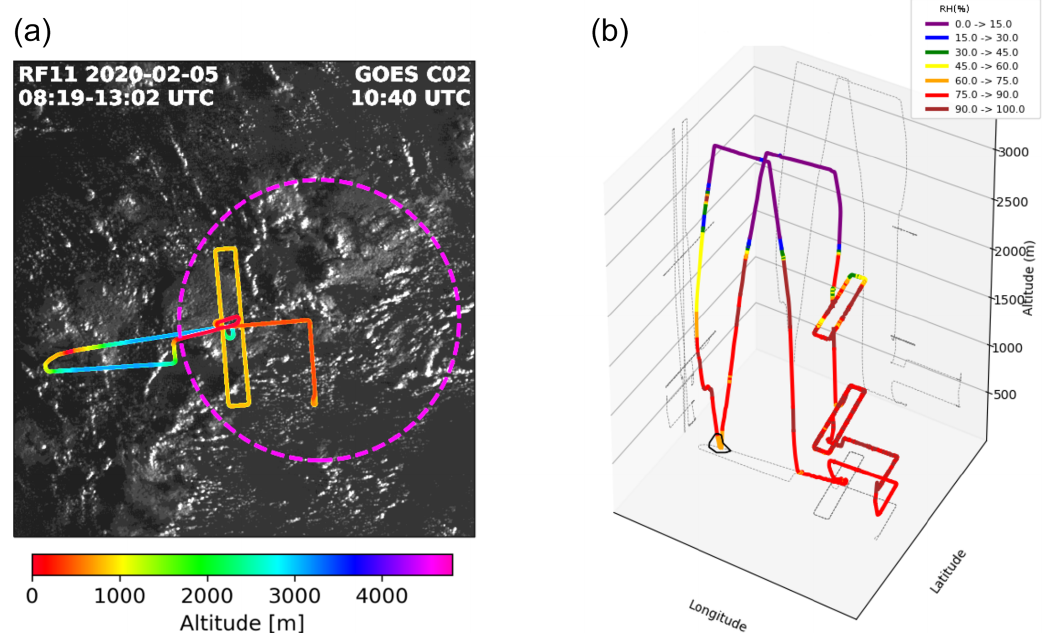
Figure 2. (a) Longitude–latitude trajectories of the ATR colored by the flight altitude (for repetitive flight patterns such as the rectangles, only the last repetition is visible due to overlap). The dashed circle represents the EUREC 4 A circle. The ATR track is shown for RF11 (5 February) on top of a satellite snapshot of the domain (11.8–14.8 ◦ N, 57–60 ◦ W) derived from the visible channel of GOES-16 at about mid-flight time (the tracks of all other flights are shown in Fig. C2). (b) Three-dimensional representation of the ATR trajectory during the same flight (RF11), colored by the relative humidity measured at the flight